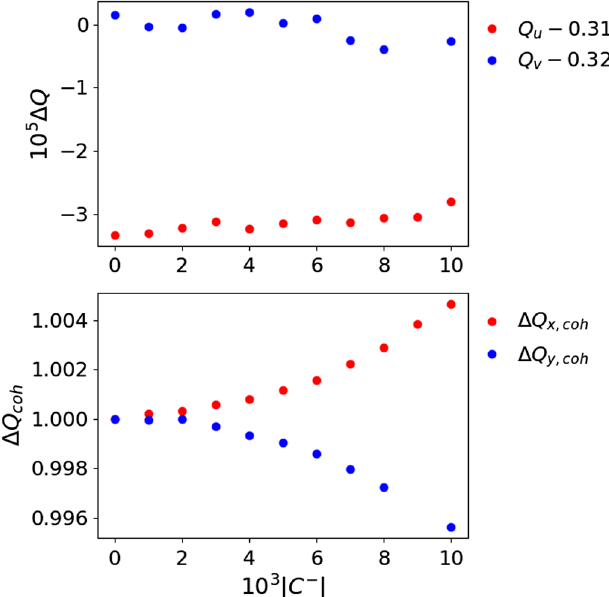
FIG. 5. Top: Simulated tunes after the introduction of linear coupling. It can be seen that all tunes are within 10 − 4 (one outlier not shown) of the required value. Bottom: Coherent tune shift of the instability as a function of the linear coupling. A variation on